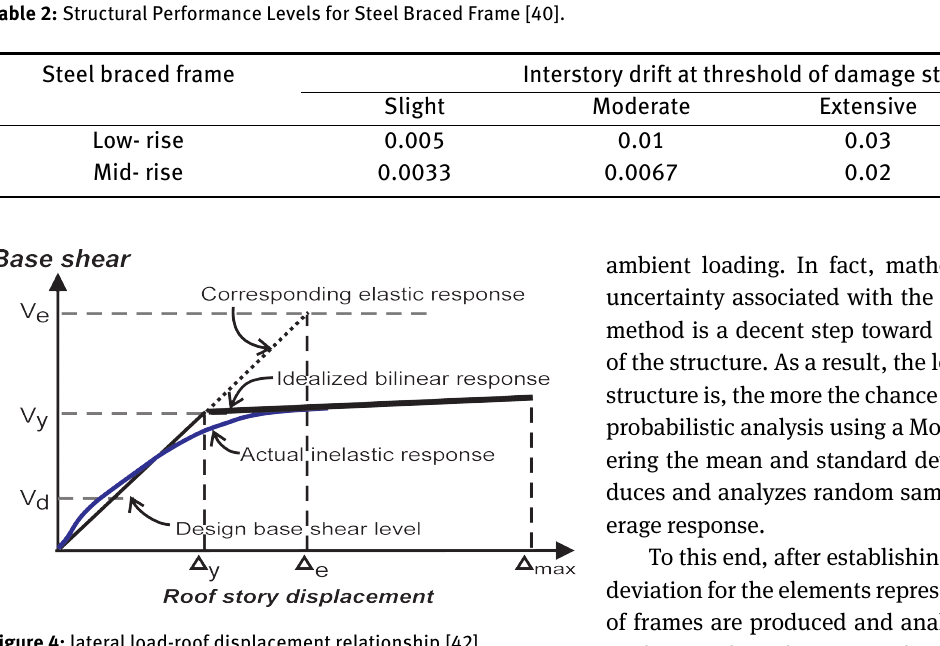
Table 2: Structural Performance Levels for Steel Braced Frame [40].